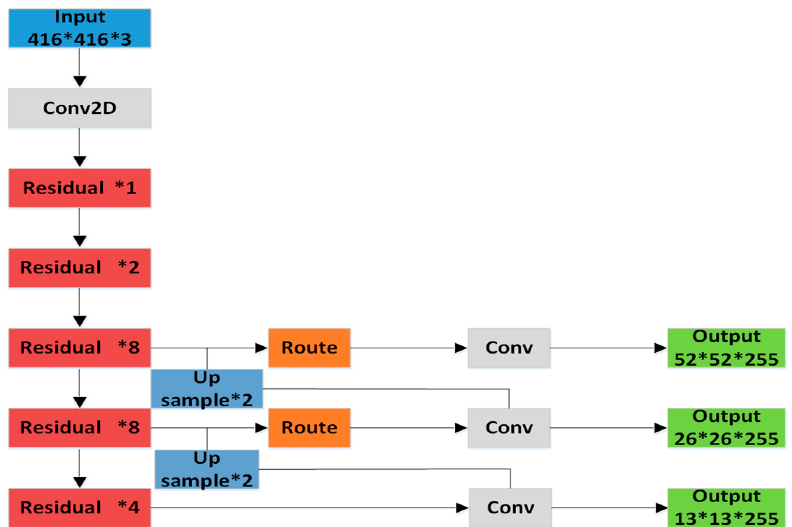
Figure 2. The network of You Only Look Once (YOLO)-v3.